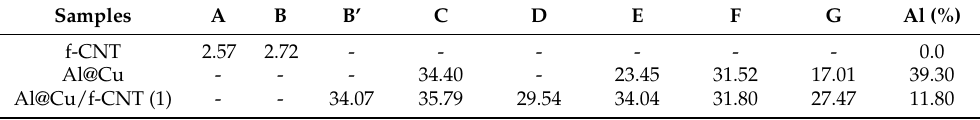
Table 2. Crystallite sizes and percentage of Al in f-CNT, Al@Cu and Al@Cu/f-CNT (1) samples.